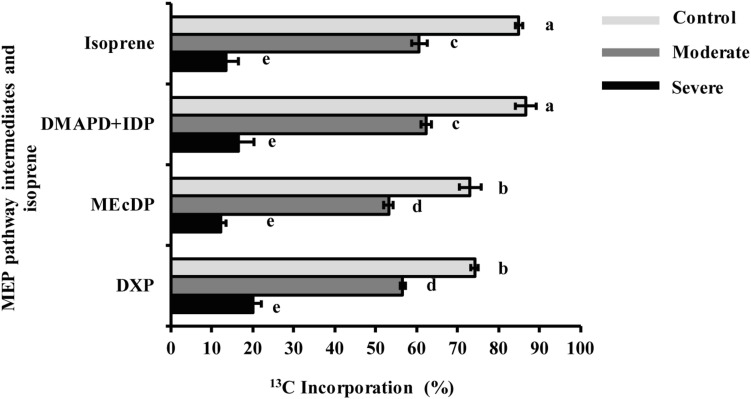
Drought decreased 13C incorporation from 13CO2 into MEP pathway intermediates and isoprene under steady state conditions after 50 min labeling. Data shown are means of five biological replicate ± SE. Different letters indicate significant differences at P < 0.05.